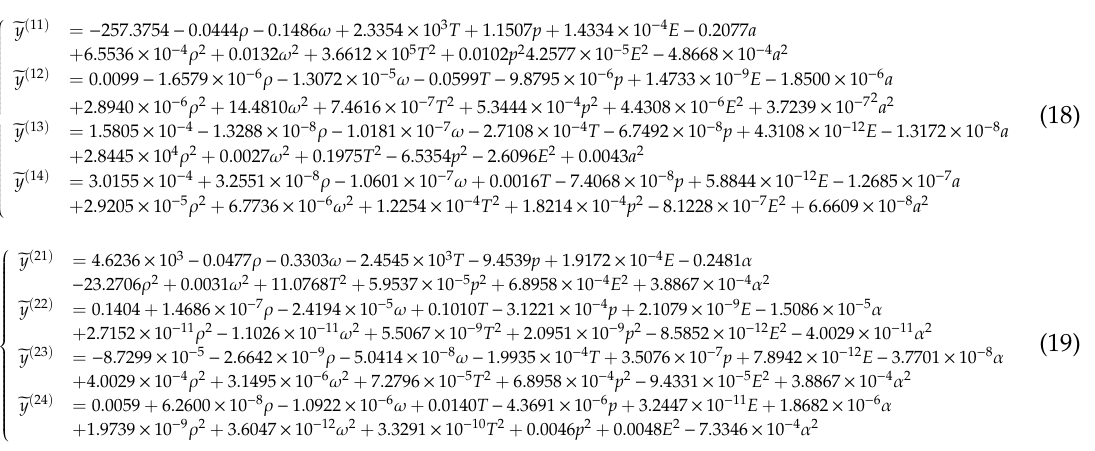
Table 2. Results of bladed disk fatigue-creep damage.